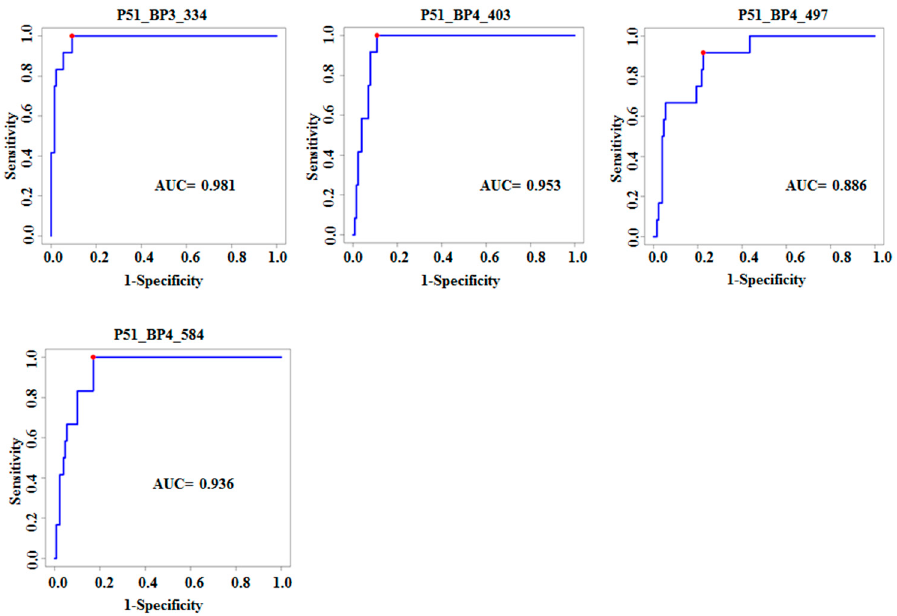
Figure 5. ROC for the top 4 significant clones that are decreased in TB sera compared to healthy controls and sarcoidosis. This figure demonstrates reasonable classification performance when classification was applied to one clone. Table 2. 10 Top Significant TB Clones.